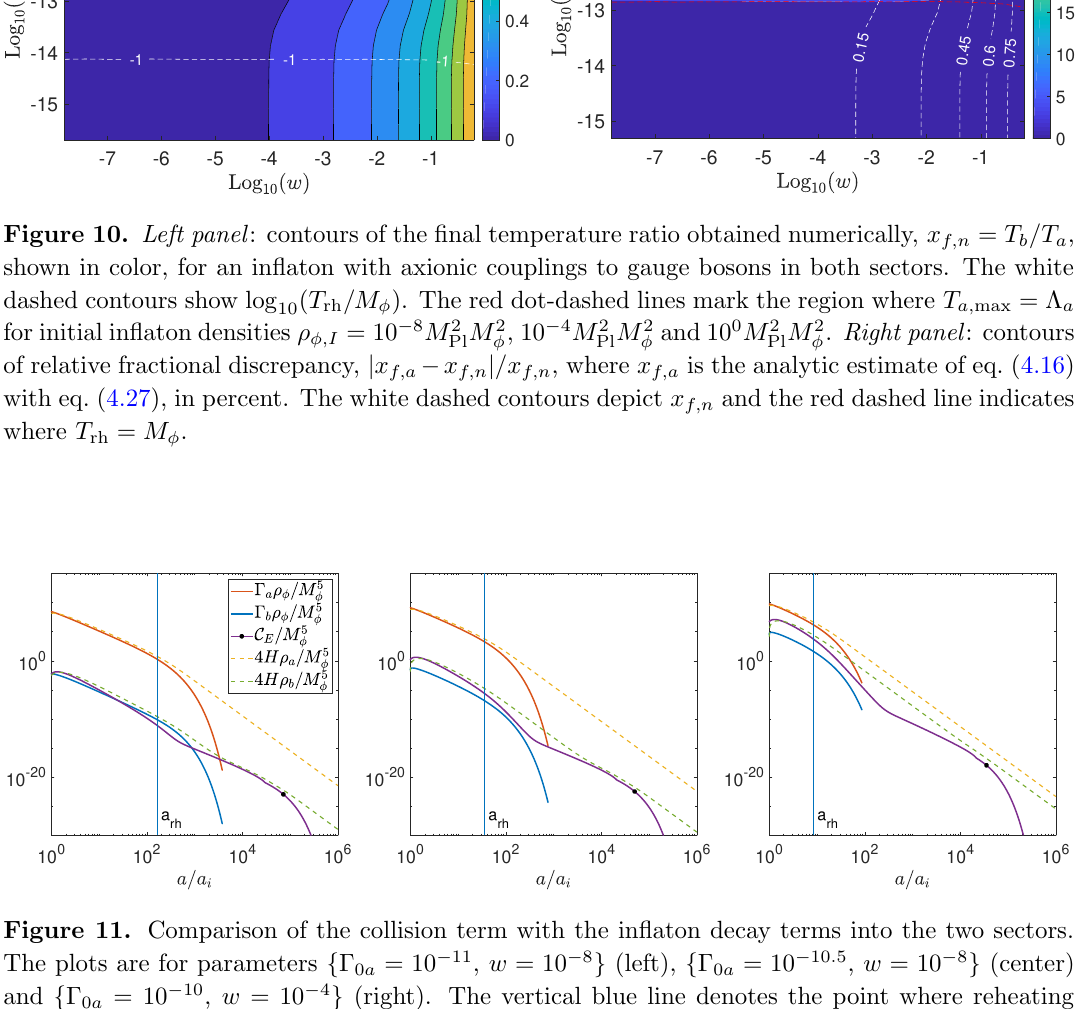
(cid:12)gure 11). It is only when the modi(cid:12)ed x plot in (cid:12)gure 11), that the e(cid:11)ects from C in the top left corner of (cid:12)gure 10. It is worth recalling that thermal e(cid:11)ects beyond